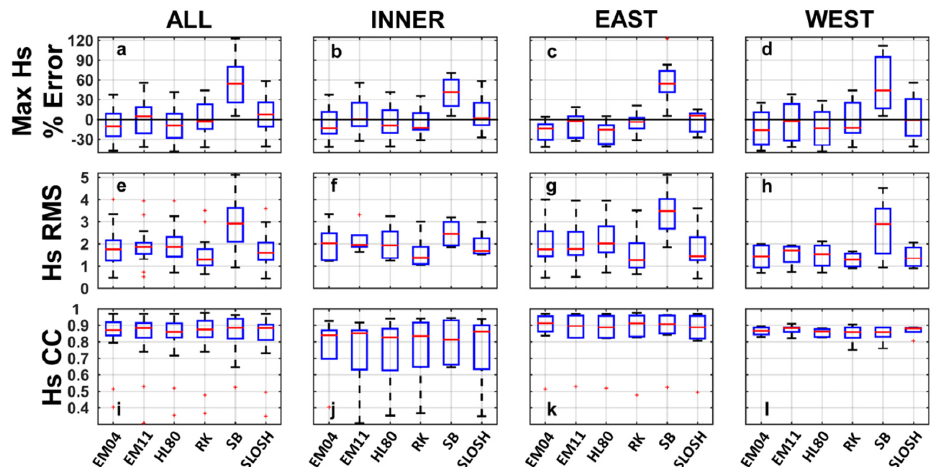
Figure 10. Boxplots of: ( a – d ) maximum Hs percent error between buoys and model results; ( e – h ) corresponding root-mean-square error; and ( i – l ) correlation coefficient. Boxplots of: ( a , e , i ) all areas; ( b , f , j ) the inner region (buoy located at a distance less than the R mw from the TC); ( c , g , k ) the east; and ( d , h , l ) the west, referring to the buoy location relative to the TC center considering the translation direction of the